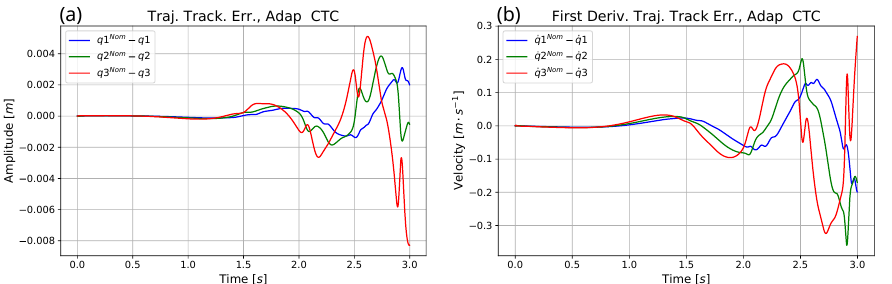
Figure 13. Trajectory tracking error ( a ) and its first time derivative ( b ) for the adaptive CTC controller using the identified parameters.